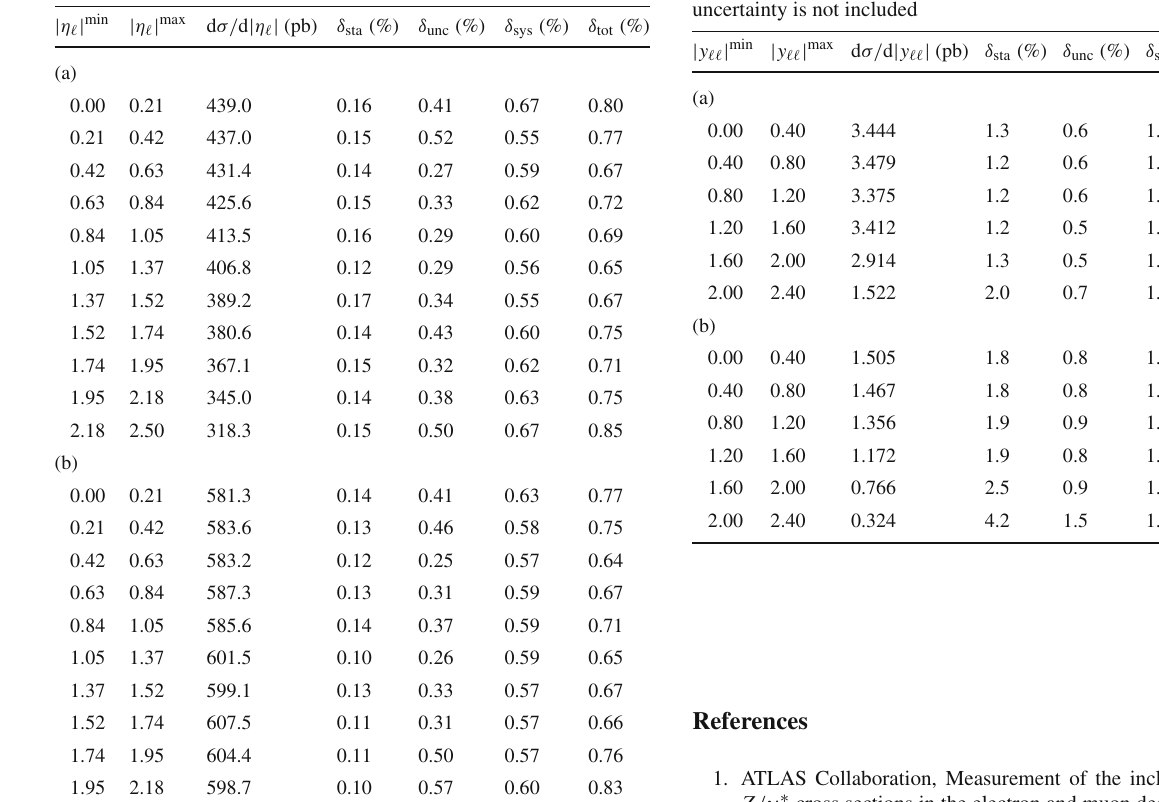
Table 27 Differential cross section for the W − → μ − ¯ ν (a) and W + → μ + ν (b) processes, extrapolated to the common fiducial region. The relative statistical ( δ sta ), uncorrelated systematic ( δ unc ), correlated systematic ( δ sys ), and total ( δ tot ) uncertainties are given in. The overall 1 . 8% luminosity uncertainty is not included